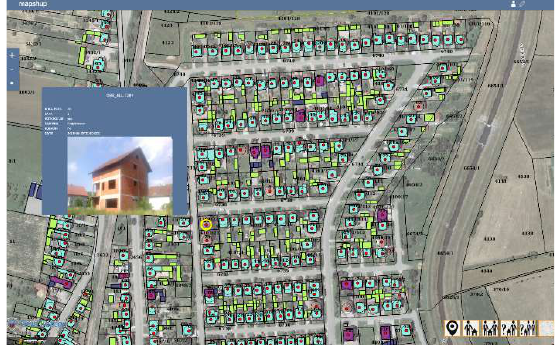
Figure 5. Web based mapshup viewer providing authorized portrayal access to field observation data, newly developed datasets of objects and cadastral parcels